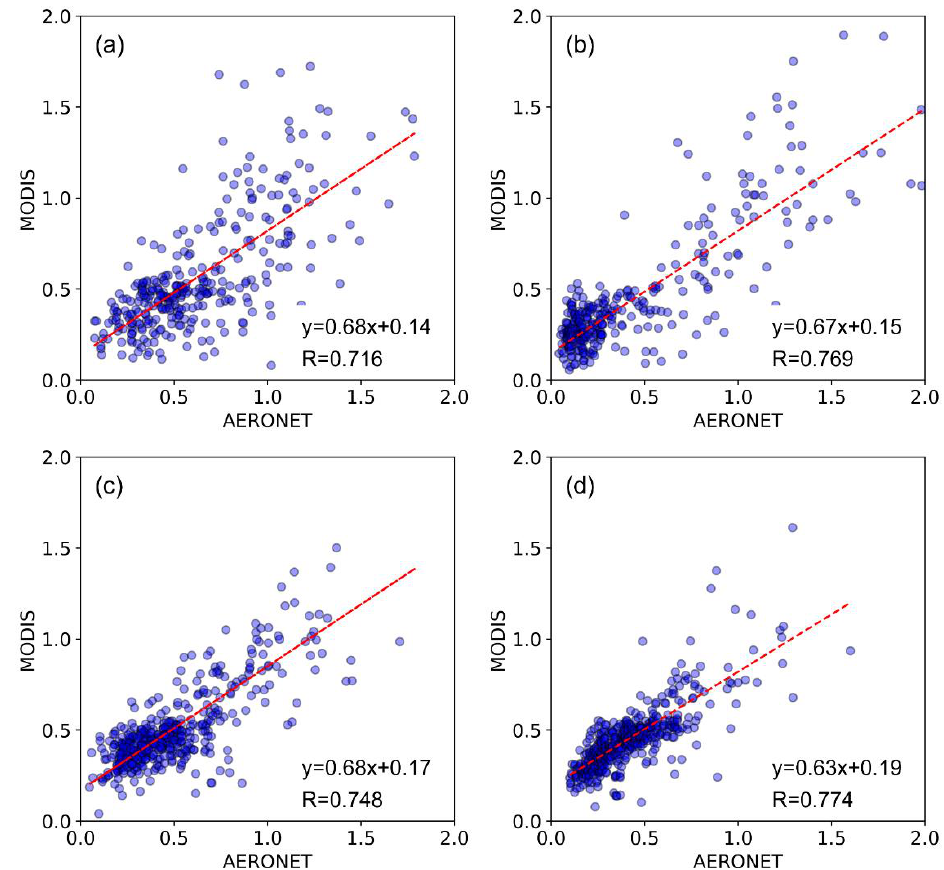
Figure 2. Scatter plots of multi-seasonal MODIS AOD data versus AERONET AOD measurements. ( a ) Spring, ( b ) summer, ( c ) autumn and ( d ) winter. The red dashed line represents the linear regres- sion line.